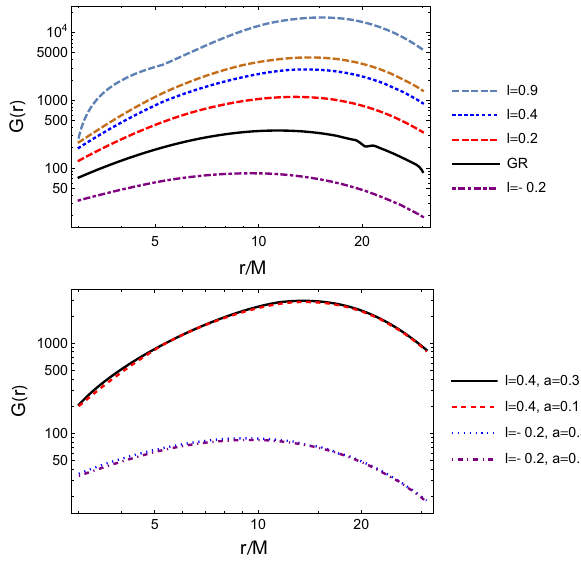
Fig. 1 Plot of G ( r ) against r / M for the isothermal disk. Upper graph: differentvaluesof l withfixedvalue0 . 3fortheslowlyrotatingparameter a . Lower graph: different values of the spin parameter a with l < 0 and l > 0